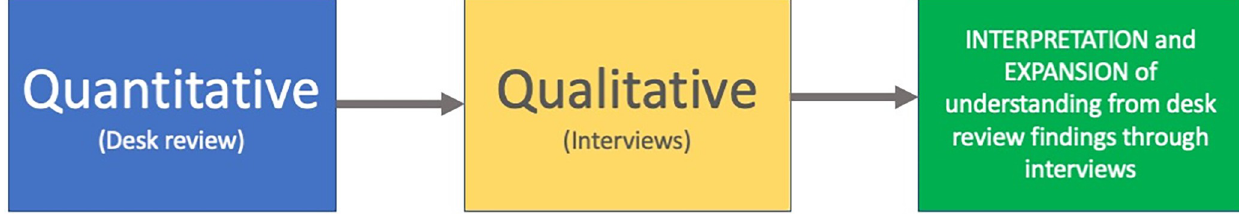
Fig 1. Study design, including use of each of the selected